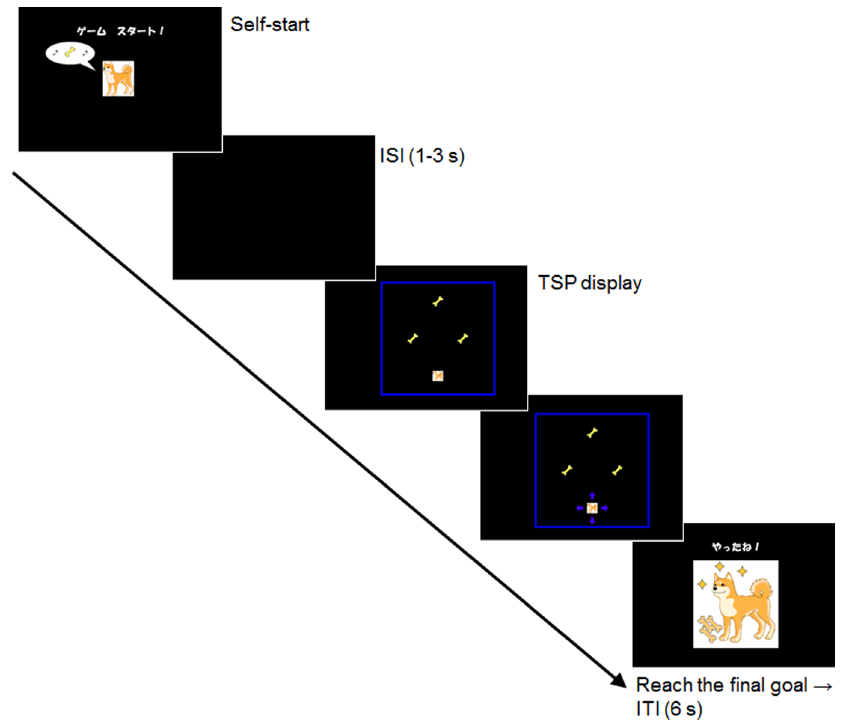
Fig. 3. Diagram showing a typical example of a trial during the test. ISI 5 interstimulus interval; ITI 5 intertrial interval. The Japanese characters on the self-start display mean ‘‘Start the game!’’ and those on the ITI display mean ‘‘You have got